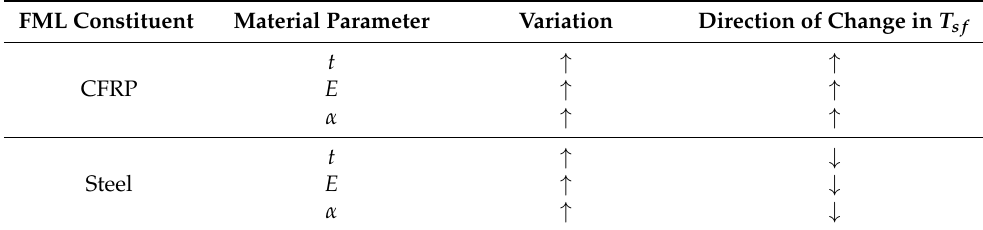
Table 8. Uncertainties in material parameters and their consequence for the analytical stress-free temperature calculation from the given radius.